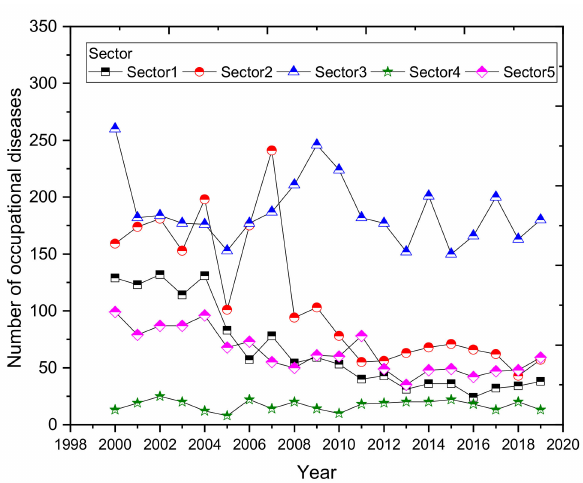
Figure 10. Development of the number of occupational diseases by economic activity sector (2000–2019).